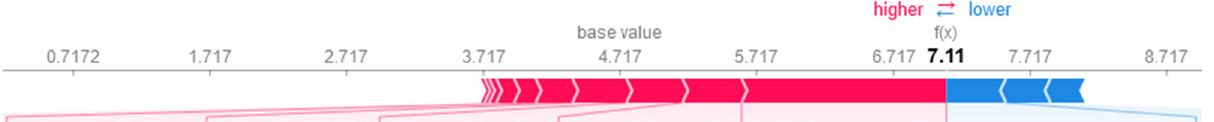
Fig 21. SHAP plot of